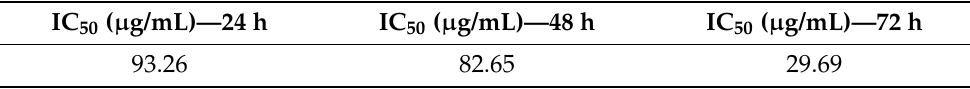
Table 5. IC 50 ( µ g/mL) values of OEO-PbH after stimulation of HaCaT human keratinocytes for different time